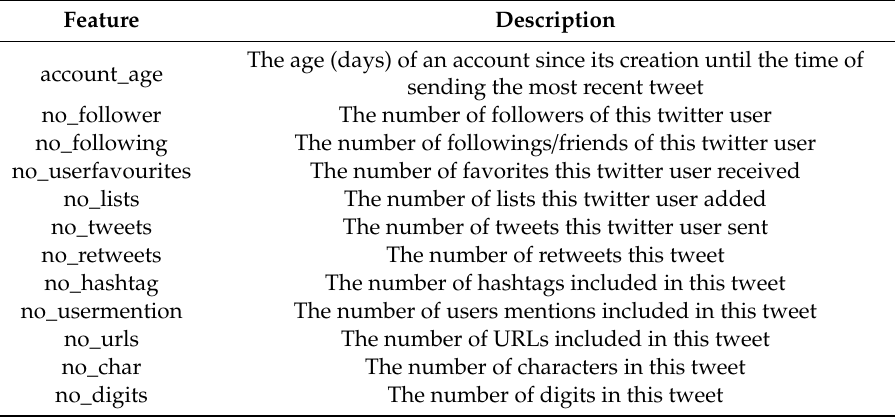
Table 2. Twitter spam dataset.